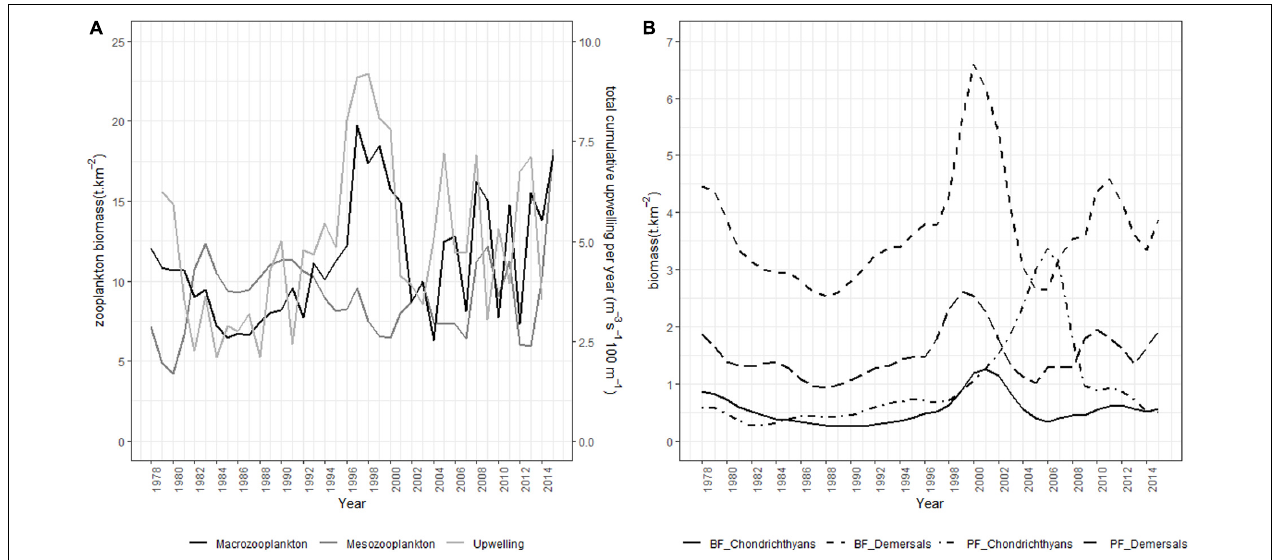
FIGURE 6 | Model trajectories from the preferred Southern Benguela model fitting scenario showing (A) meso-and macro-zooplankton dynamics in relation to total cumulative upwelling, and (B) demersal and chondrichthyan stock dynamics.